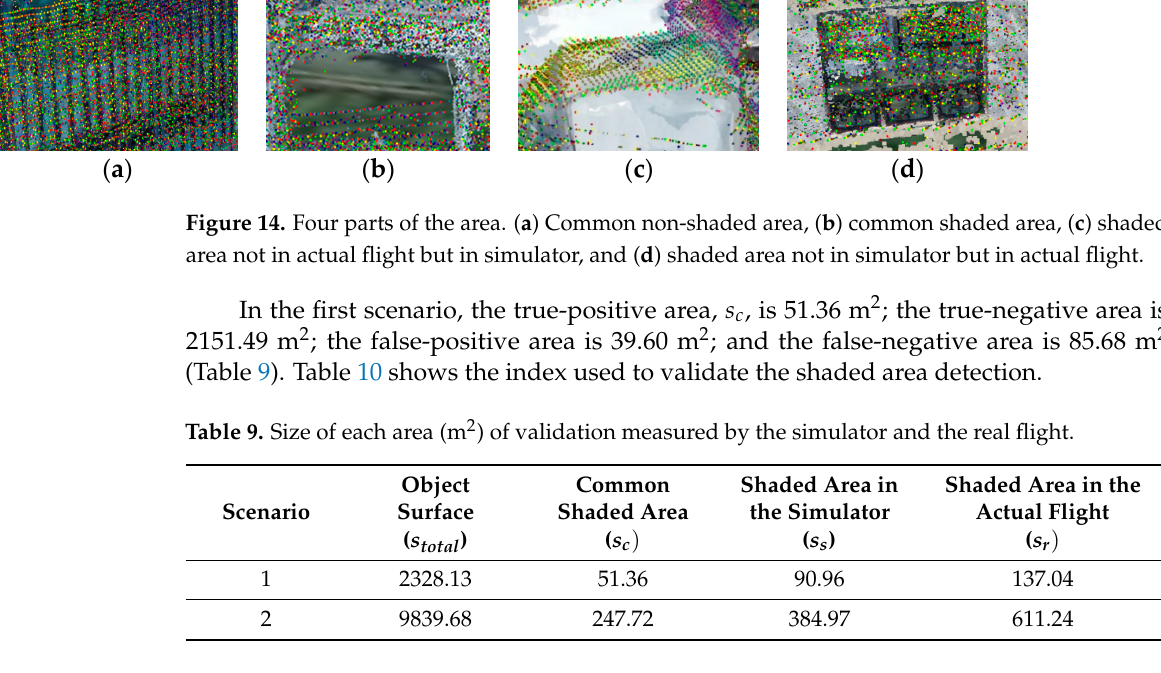
Table 10. Shaded area detection performance of the simulator. Index Scenario 1 Scenario 2